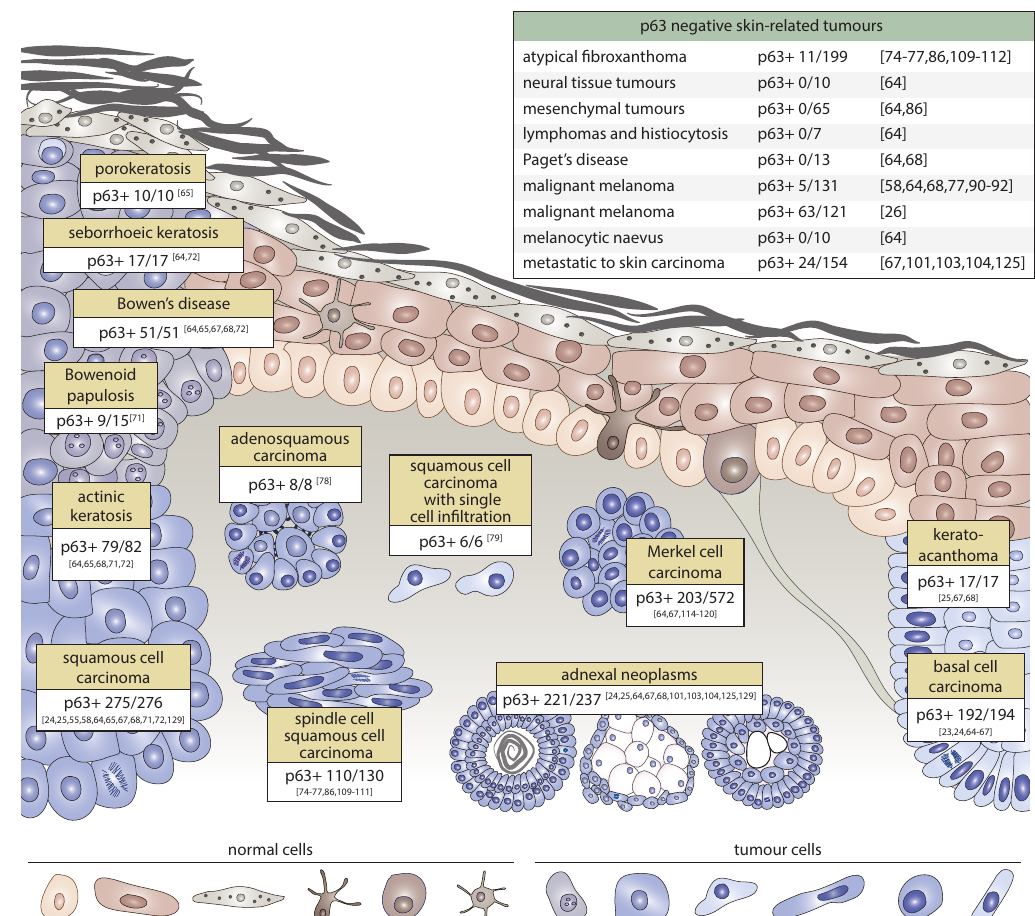
Figure 2. p63 expression in skin cancer. p63 positively marks both benign precancerous lesions (seborrheic-, actinic-, and porokeratoses, keratoacanthoma, Bowen’s disease, and Bowenoid papulosis) and malignant tumours of the skin (basal cell carcinoma, squamous cell carcinoma, spindle cell squamous cell carcinoma (SCC), adenosquamous carcinoma, and SCC with single cell infiltration). Multiple adnexal neoplasms of both a benign and malignant character stain intensively for p63. Merkel cell carcinoma shows positive p63 expression in less than 50% of cases; indeed, its expression is correlated with poor prognosis of Merkel cell carcinoma (MCC). By contrast, neural tissue, mesenchymal tissue tumours, cutaneous lymphomas and histiocytosis, Paget’s disease, and atypical fibroxanthoma lack p63 in most cases. Metastatic carcinoma to skin stains positively for p63 in only 15% of cases. Melanocytic naevi as well as malignant melanoma are virtually all p63 negative, with the exception of one report